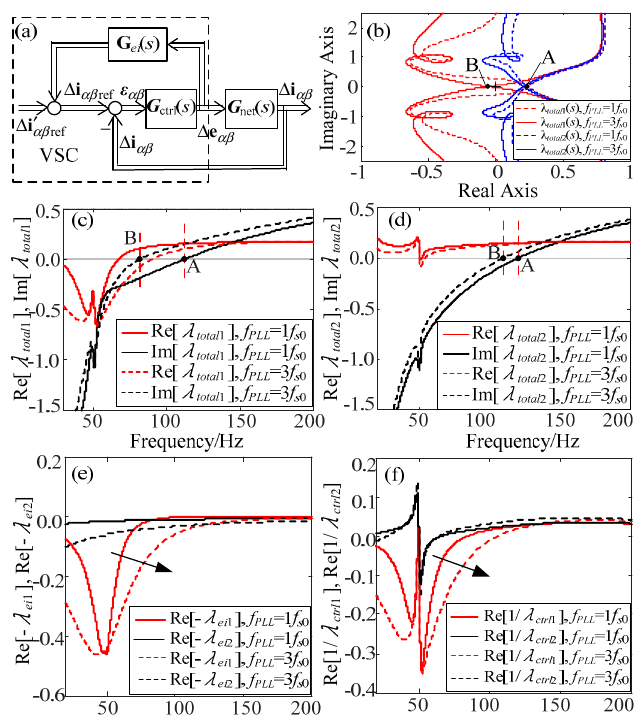
Figure 9. The system block diagram and frequency characteristic curves of the system transfer function matrix: ( a ) the block diagram of the studied system, ( b ) the Nyquist curves of the characteristic loci in G total ( s ), ( c ) the real and imaginary part of λ total 1 (j ω ) with changing PLL bandwidth, ( d ) the real and imaginary part of λ total 2 (j ω ) with changing PLL bandwidth, ( e ) the real part of − λ ei 1,2 (j ω ), ( f ) the real part of 1/ λ ctrl 1,2 (j ω